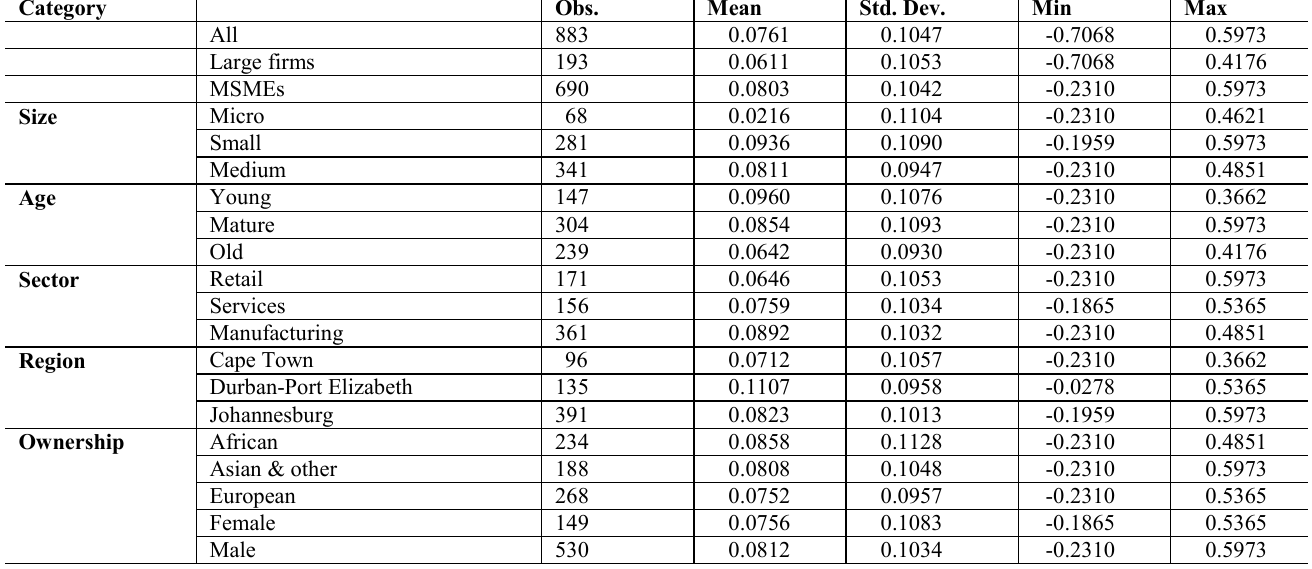
Table 2: Employment growth rates by enterprise